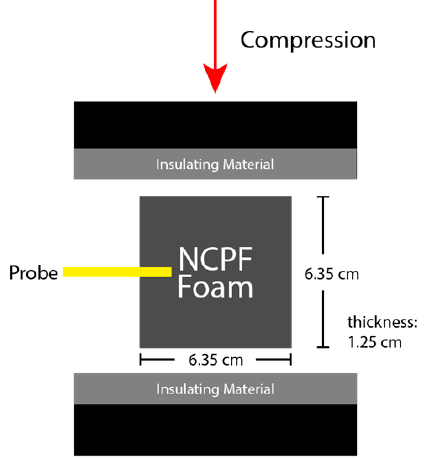
Figure 2. Schematic depicting experimental setup for cyclic testing NCPF samples utilizing probes to measure dynamic loading voltage response.